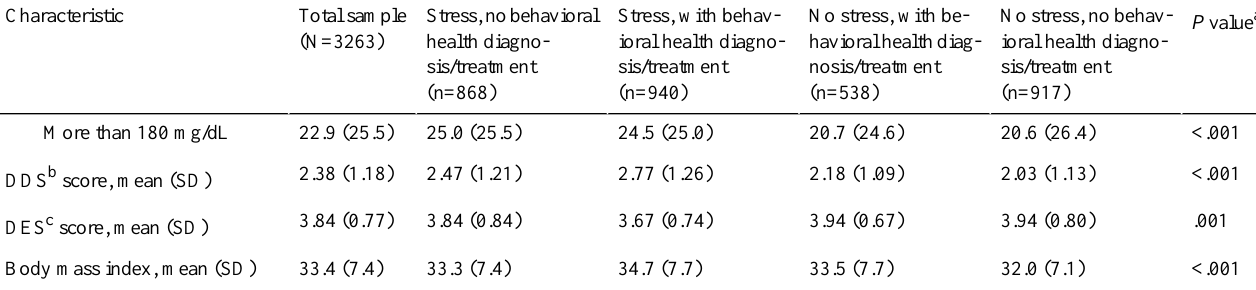
Table 2. Blood glucose checking frequency and values during the 12-month period following study index date. (n=868)Characteristic